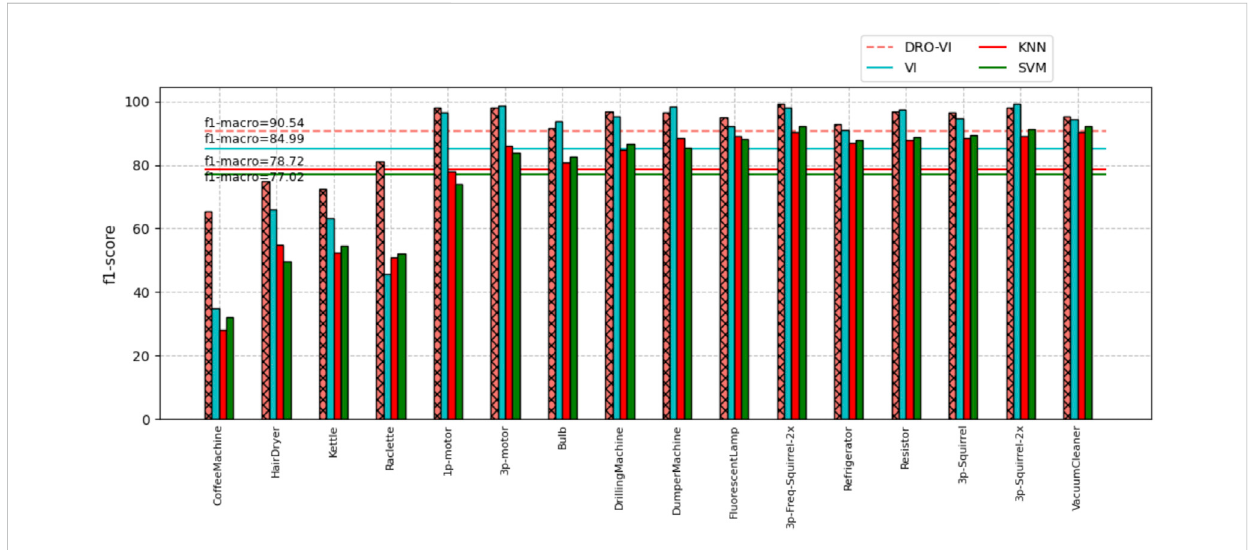
FIGURE 5 F1-score of appliance loads for the LILACD with the V-I trajectory.